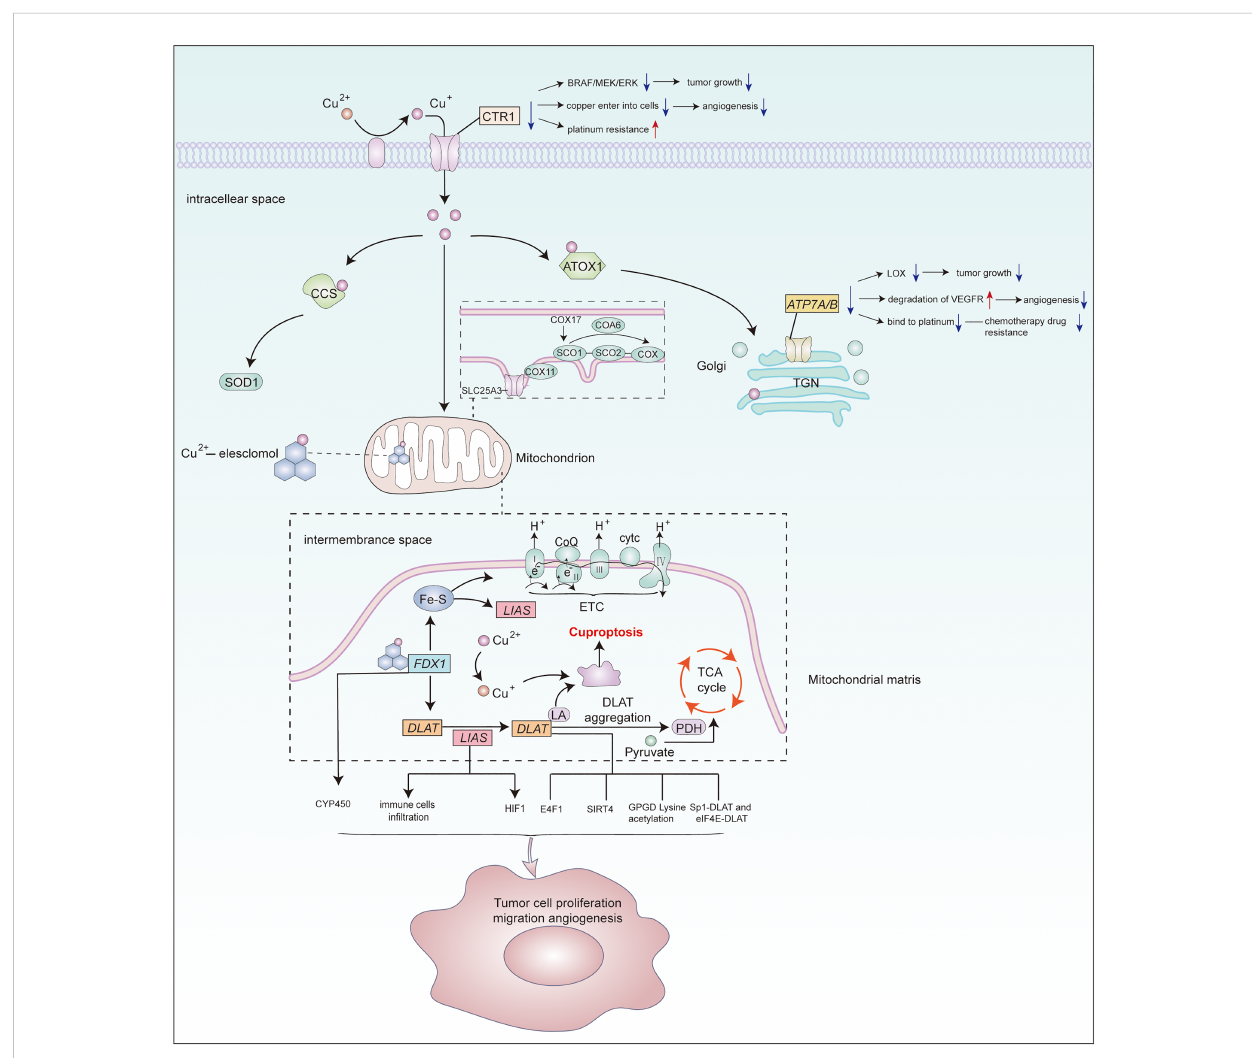
FIGURE 1 Potential association of cuproptosis – related genes and copper transporters with cancer. Metal reductase STEAP reduces extracellular Cu 2+ to Cu + , then CTR1 transfers Cu + from outside the cell into it.Cytoplasmic and mitochondrial metallochaperones (ATOX1, CCS, SCO1, SCO2, COX11, COX17) working in concert to ensure targeted insertion of copper into metalloprotein.In mitochondria,copper enters it through SLC25A3 for storage.COA6 and SCO2 help to maintain the redox balance of SCO1 and in turn its copper binding and delivery to COX.ATP7A and ATP7B perform copper export function.Copper can induce cuproptosis by binding to lipid-acylated TCA cycle components, promoting lipid-acylated protein aggregation, and inducing protein stress.Vital regulatory genes in cuproptosis or copper homeostasis may regulate various molecules or signaling pathway to affect cancer progression. However, the speci fifi c mechanisms require further